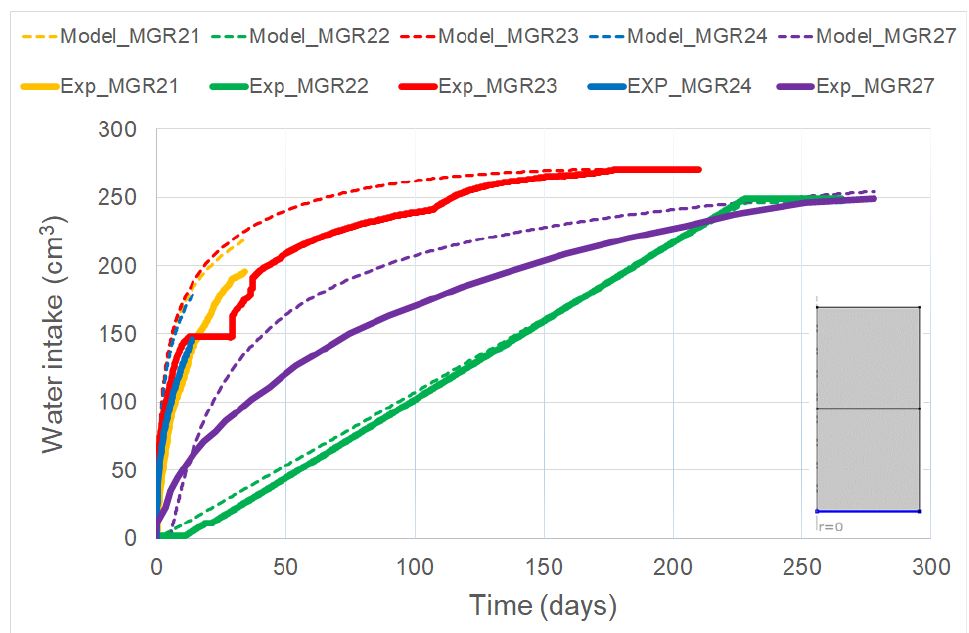
Figure 3. The comparison of the modeling results (dashed lines) and the measurements (solid lines) of water intake to the bentonite samples.